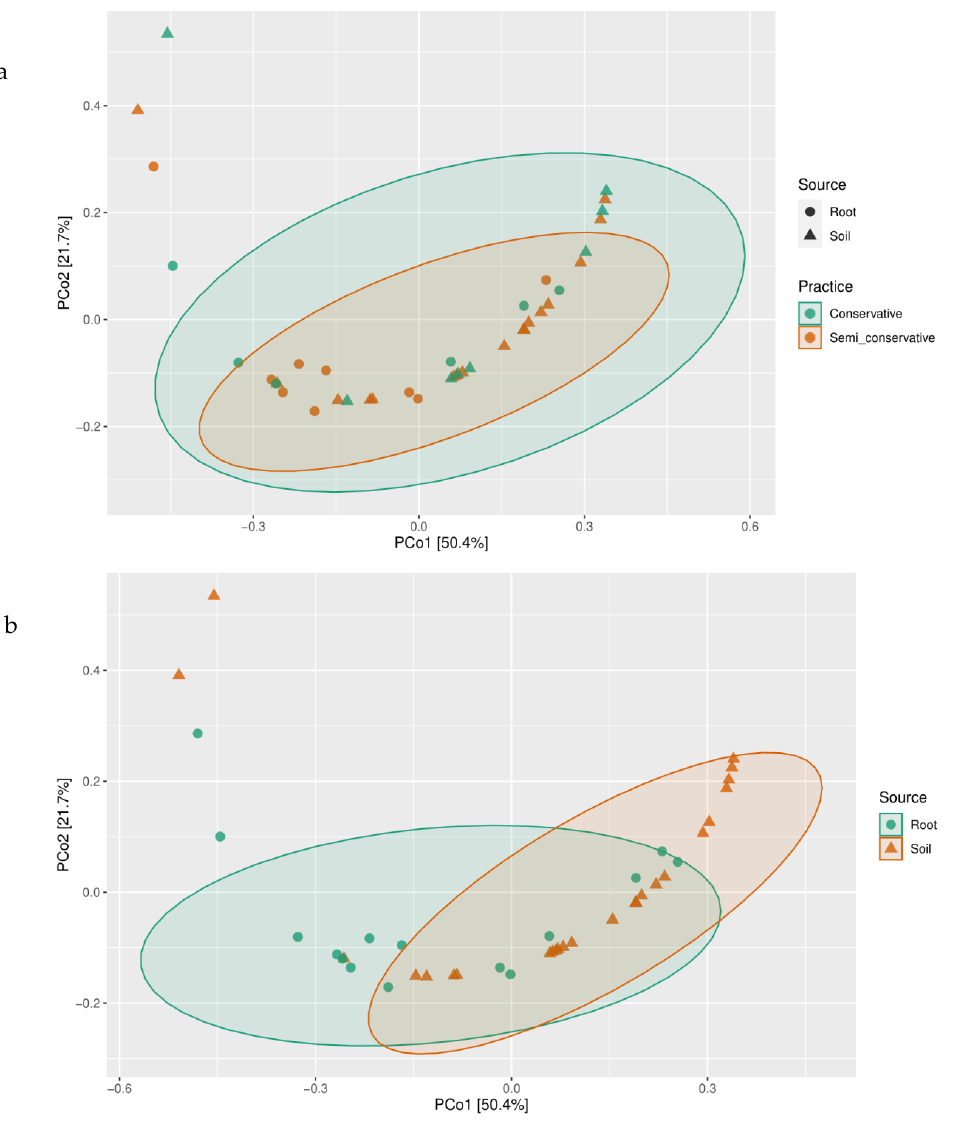
Figure 6. Principal coordinate analysis of the Bray-Curtis dissimilarity index comparing samples from ( a ) soil and roots with ( b ) cocoa cultivation practices (conservative and